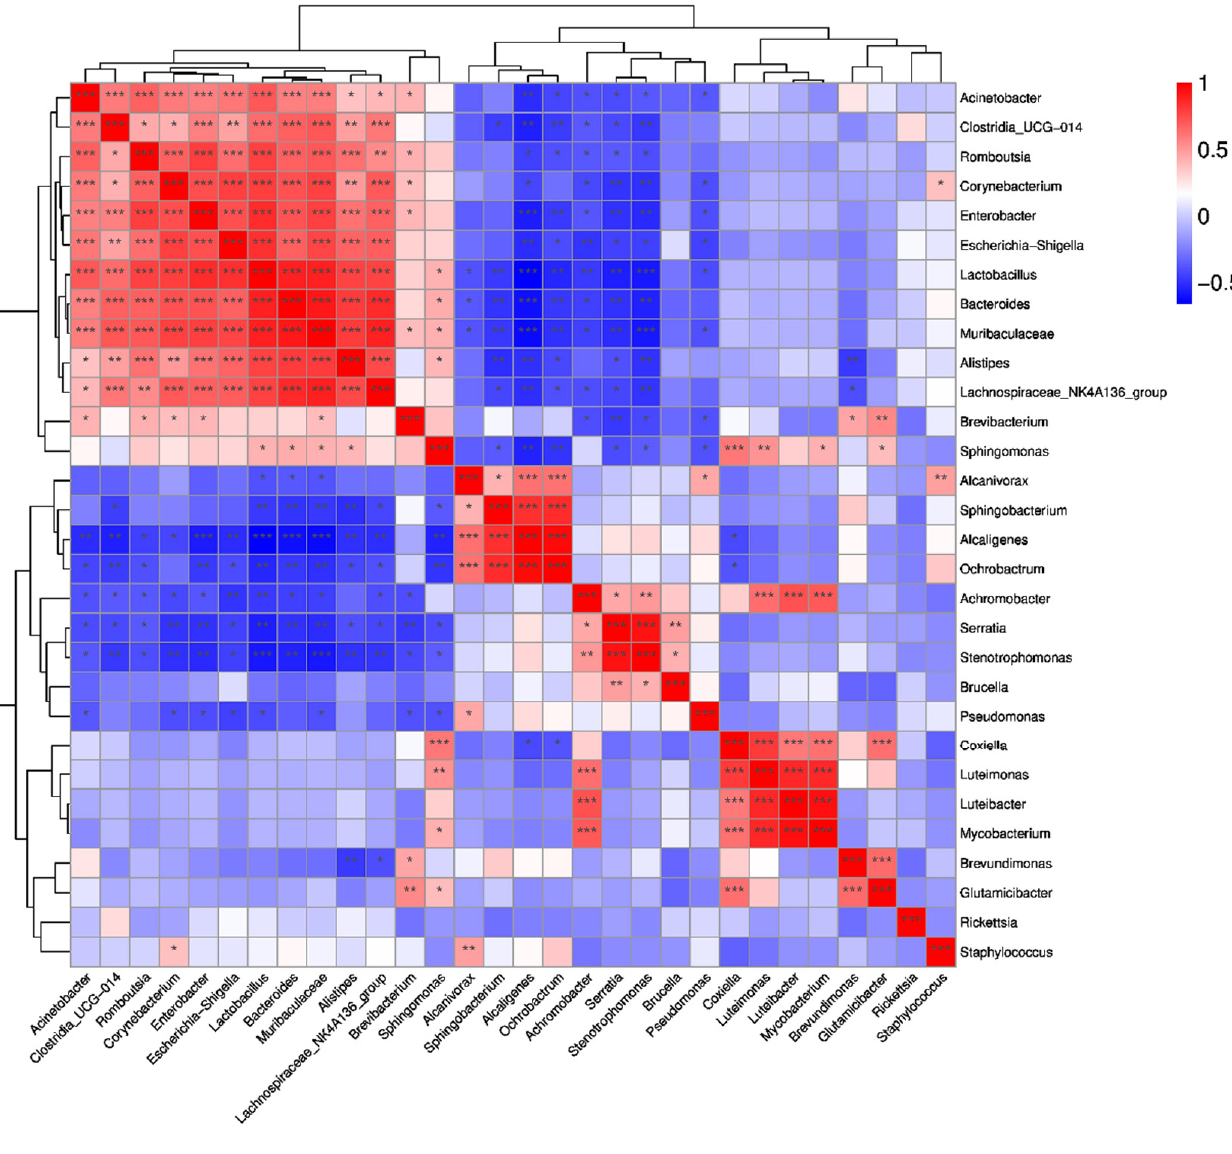
Figure 8. Correlation heatmap of Spearman coefficient of the top 30 genera of the groups of H. flava and H. longicornis samples (* p < 0.05, ** p < 0.01,*** p < 0.001). The groups of H. flava are CCF, OSDF, ISDF and CMIF and the groups of H. longicornis are CCL and CMIL.